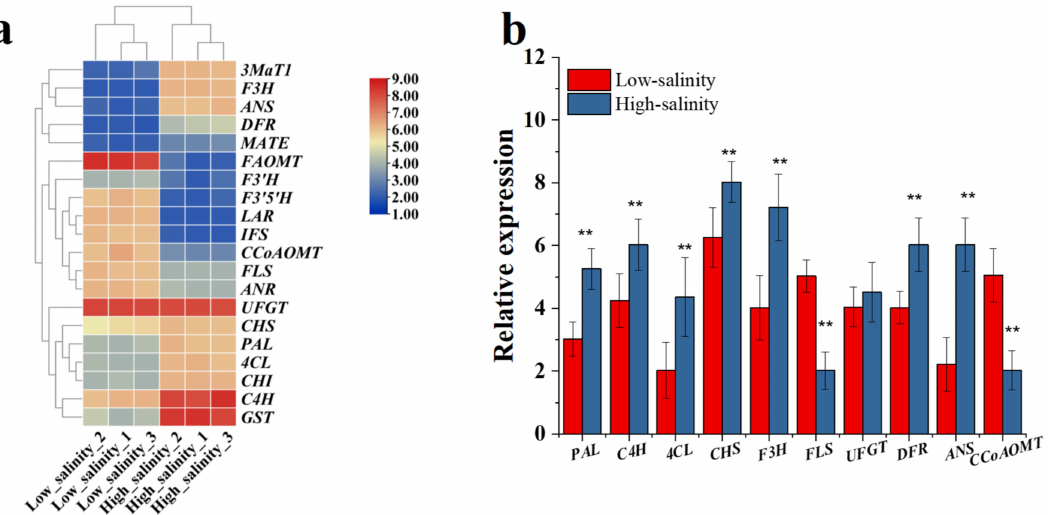
Figure 10. Absence of the polyphenol synthesis genes expression in different salinity groups. ( a ) Expression of major genes involved in the polyphenol synthesis in response to the different salinity. A heatmap is constructed by FPKM (Z-score method) in storage root of purple sweetpotato. ( b ) Changes of key genes validated by RT-PCR compared to RNA-Seq analysis. Datasets with the same letter do not significantly differ (** p <